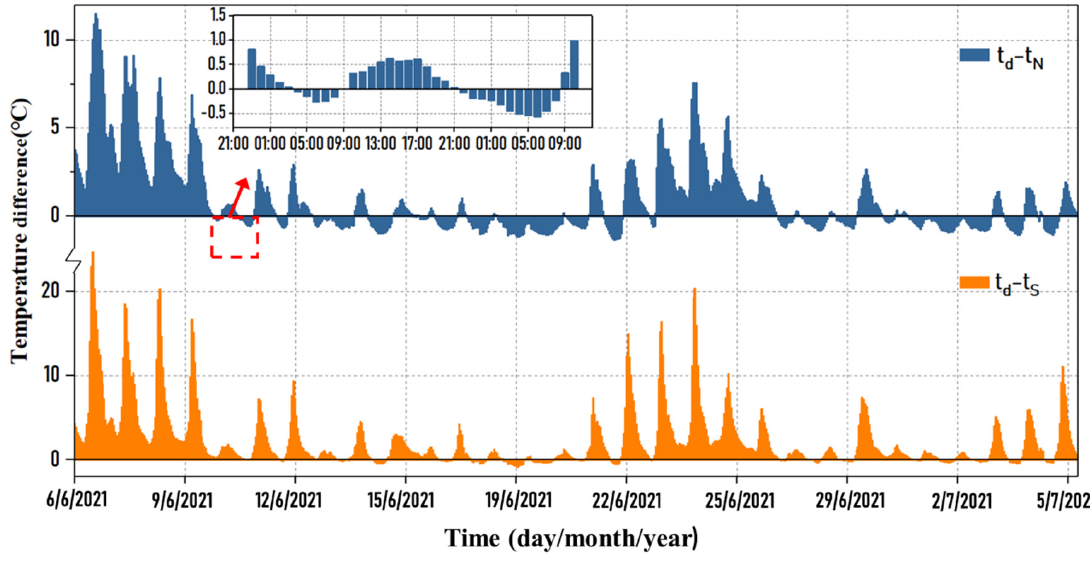
Figure 9. Difference between the dew point temperature and the wall surface temperature.